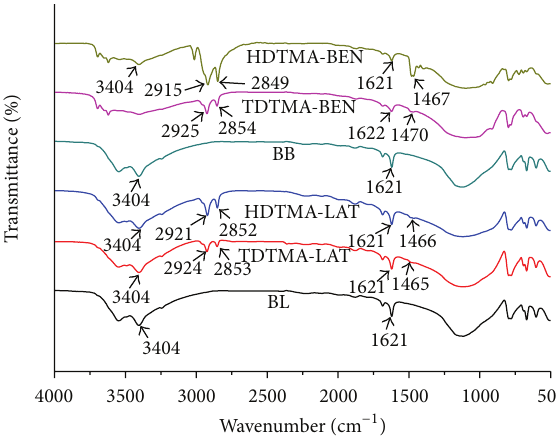
Figure1:TheFT-IRspectraofunmodifiedandmodifiedlateriteand bentonite with TDTMA and HDTMA (BL: blank laterite; BB: blank